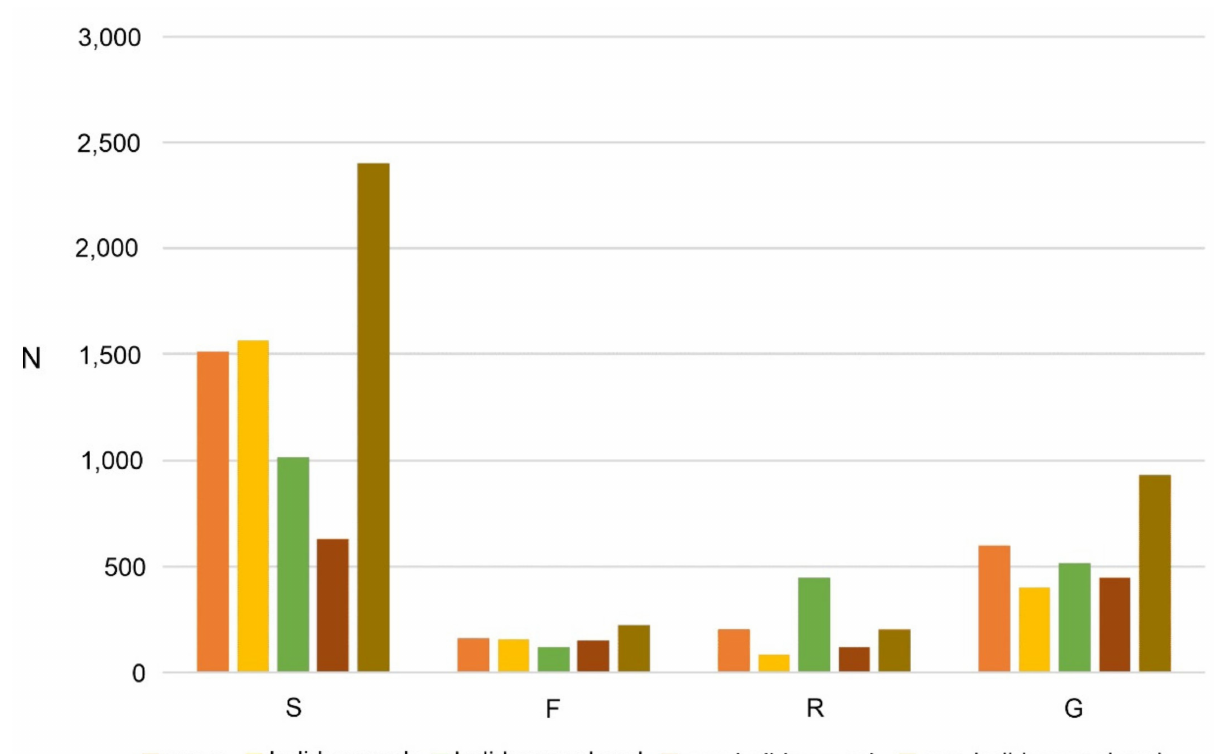
Figure 3. Number of visitors to the study sites in one short period (S—open swimming pools, F—multi-media fountain, R—reservoir, G—gravel pit lake).